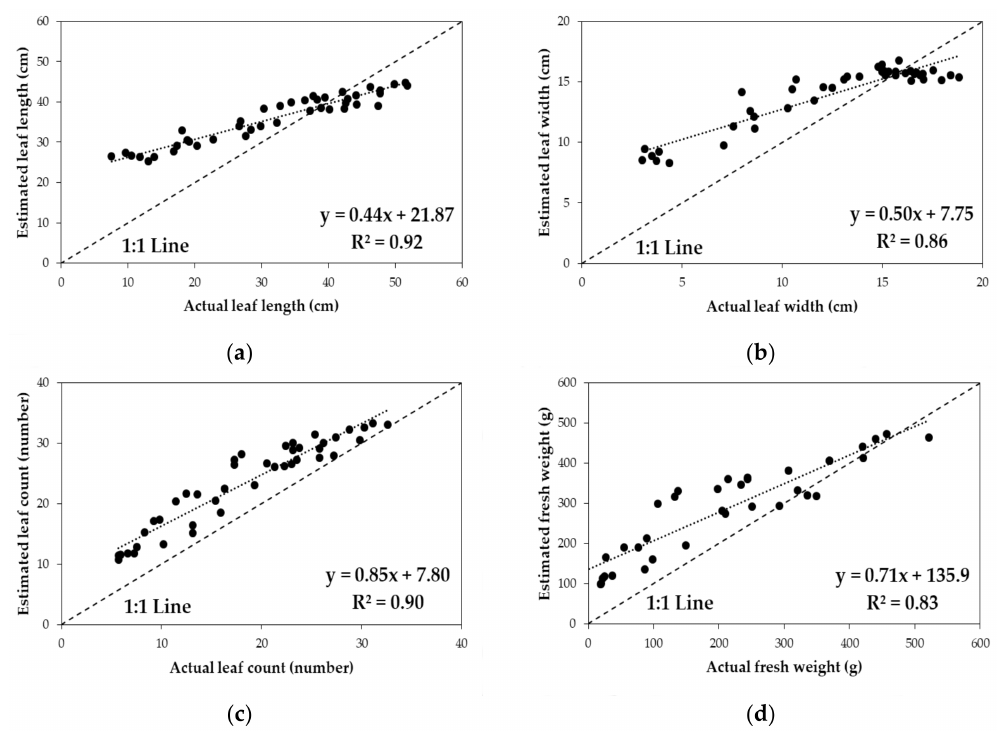
Figure 13. Relationships of biophysical properties (( a ) leaf length; ( b ) leaf width; ( c ) leaf count; and ( d ) above-ground fresh weight of white radish determined by the derived unmanned aerial vehicle (UAV)-estimated models and by standard